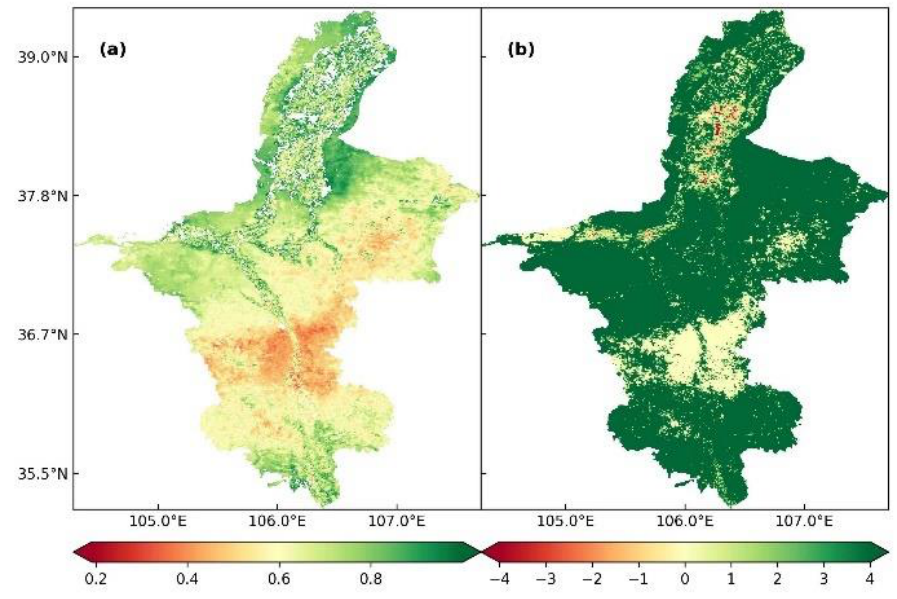
Figure 9. ( a ) Spatial distribution of the Hurst index (H) in Ningxia. ( b ) Future trend of ET in Ningxia. Table 2. Statistics of ET trends and the Hurst index (H).